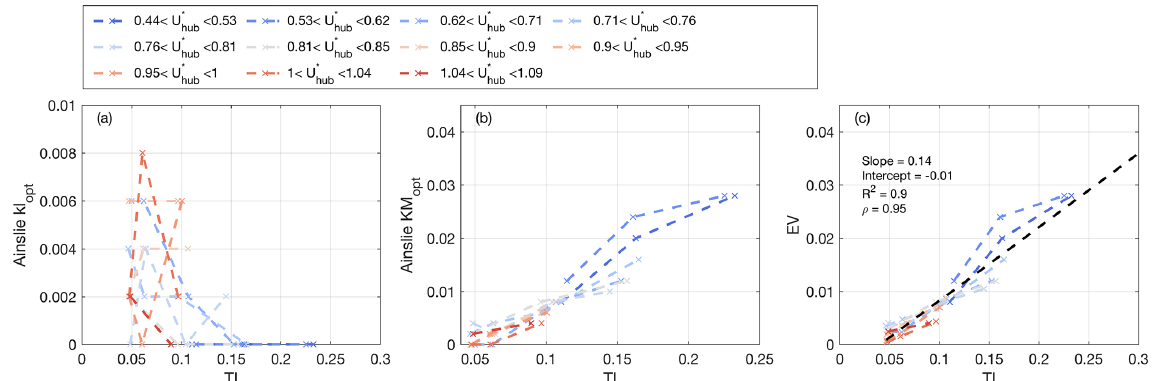
Figure 8. Optimal tuning of the parameters for the Ainslie wake model: (a) k l , (b) K M , and (c) eddy viscosity versus the incoming-turbulence intensity of each lidar cluster, while the lines are colored by the hub-height velocity. The dashed black line represents linear fitting.